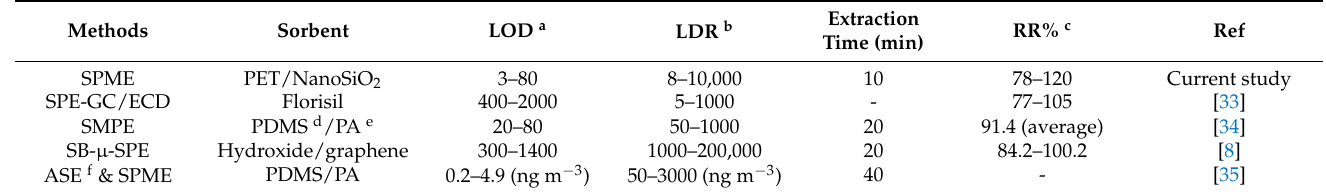
Table 3. Comparison of HS-SPME/GC-ECD with other published method for determination of